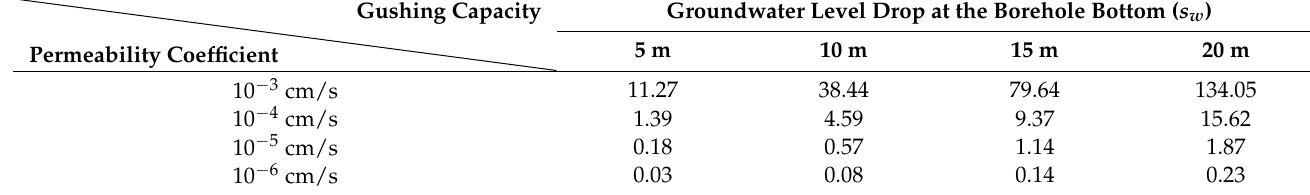
Table 2. Single borehole gushing